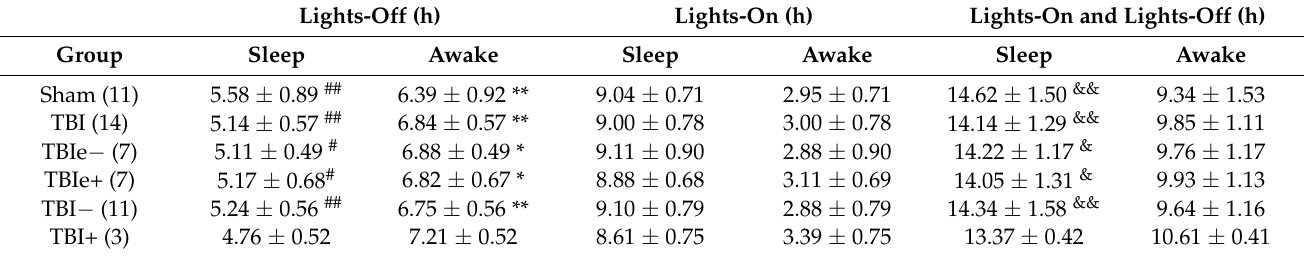
Table 2. Duration of waking and sleep periods during the lights-on and lights-off periods in different groups.